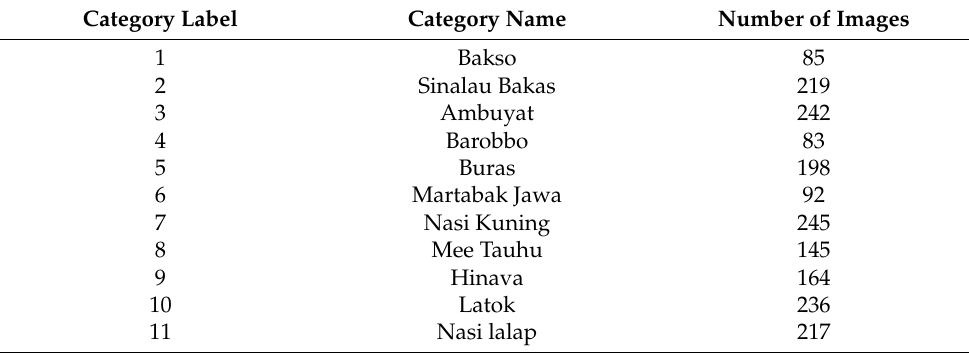
Table 2. Image number for each category of food items for Sabah Food Dataset.